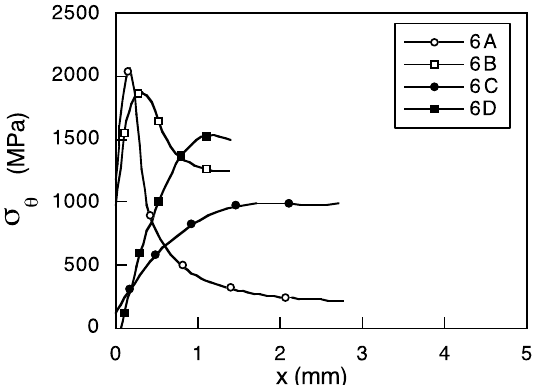
Figure 12. Distribution of hoop stress in notched samples of steel A6.